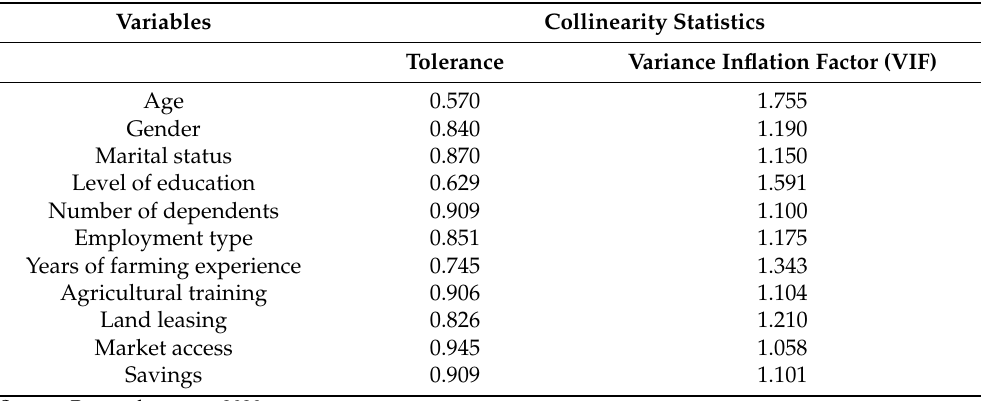
Table 7. Multicollinearity test for explanatory